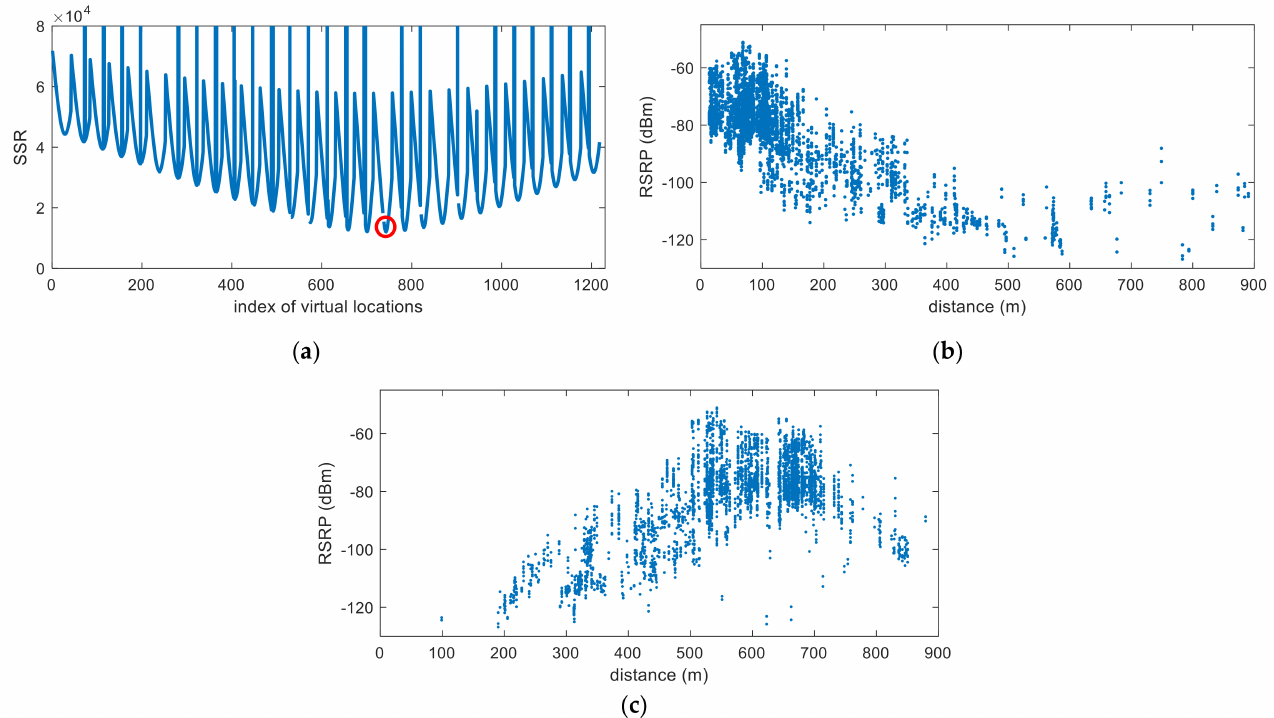
Figure 6. SSR and distance–RSRP information according to VL. ( a ) SSR according to VL; ( b ) distance– RSRP information reconstructed based on the VL with the minimum SSR value; ( c ) distance-RSRP information reconstructed based on an arbitrary VL.